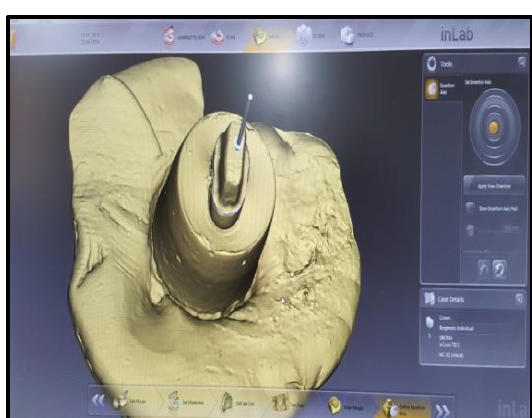
Figure 4: Scanning of die stone using inEos X5 Blue scanner